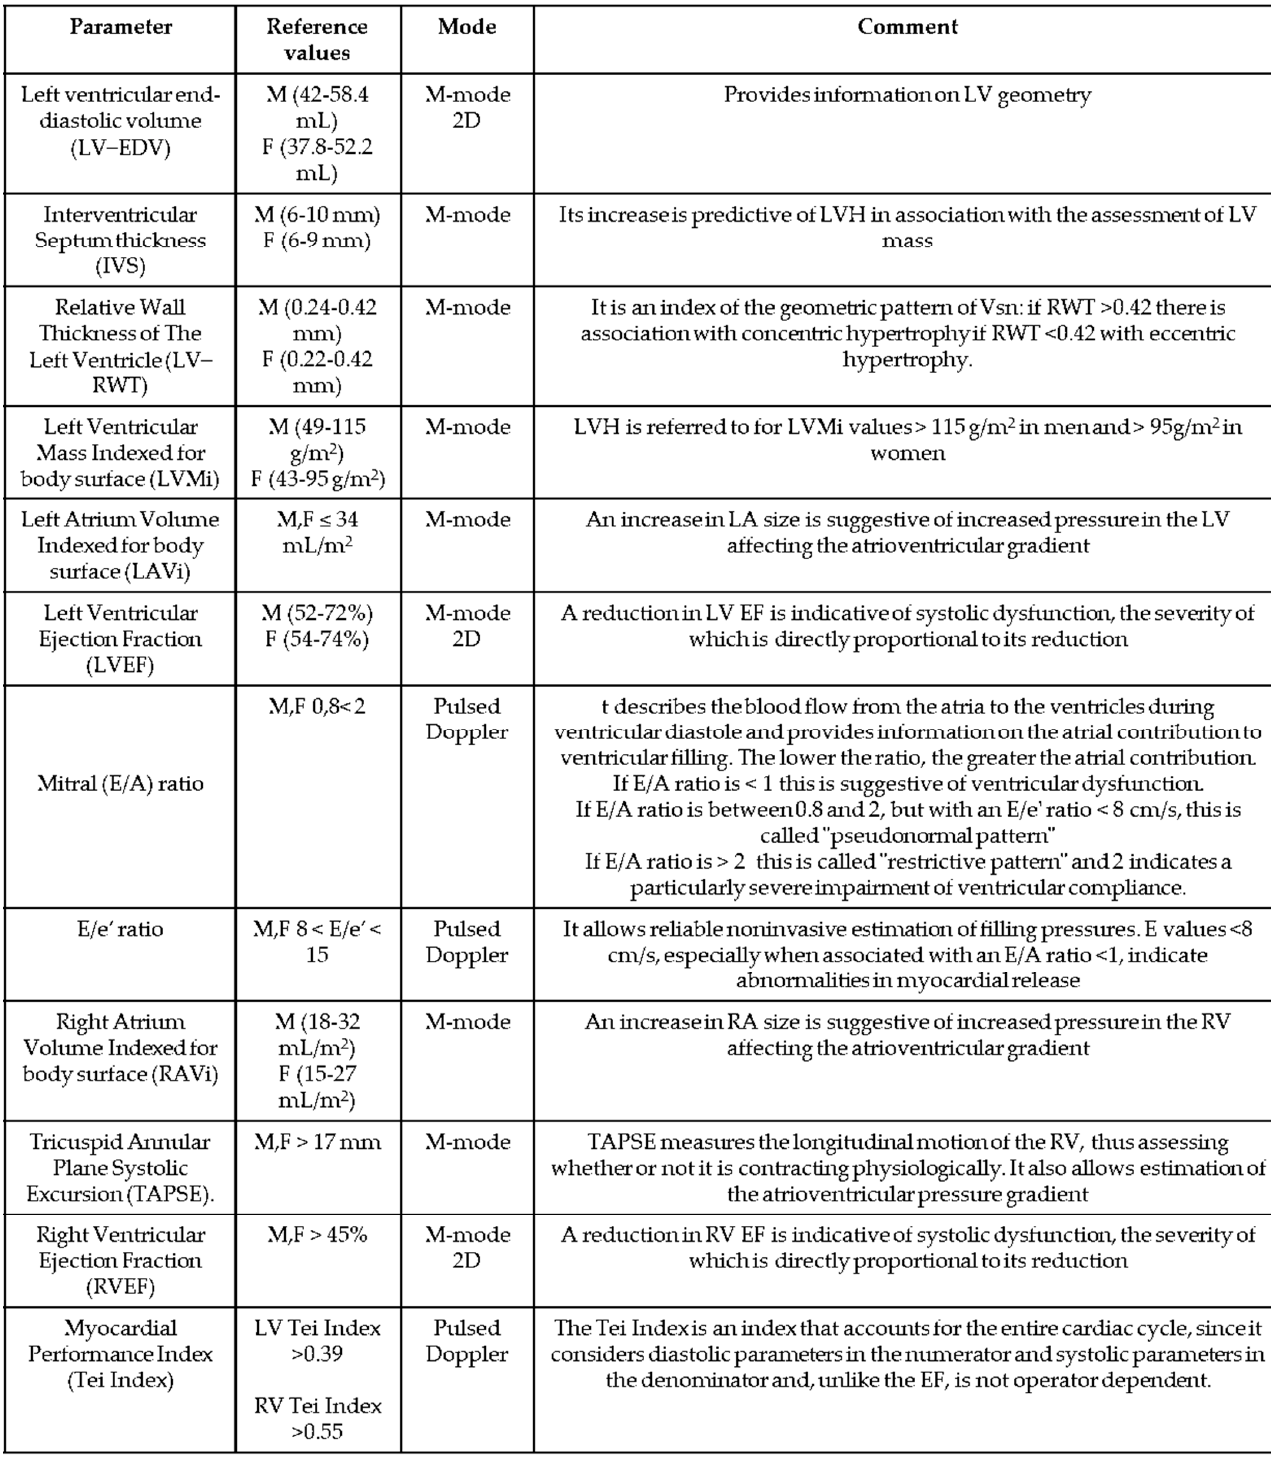
Figure 1. List and characteristics of the echocardiographic parameters evaluated in the study. 2.4. For the Left Ventricle (LV) - Left ventricular end-diastolic volume measured in ml (LV-EDV). We considered reference values ranging from 42 and 58.4 mL for men and 37.8 and 52.2 mL for women. - Interventricular septum thickness (IVS). We considered reference values ranging from 6 and 10 mm for men and 6 and 9 mm for